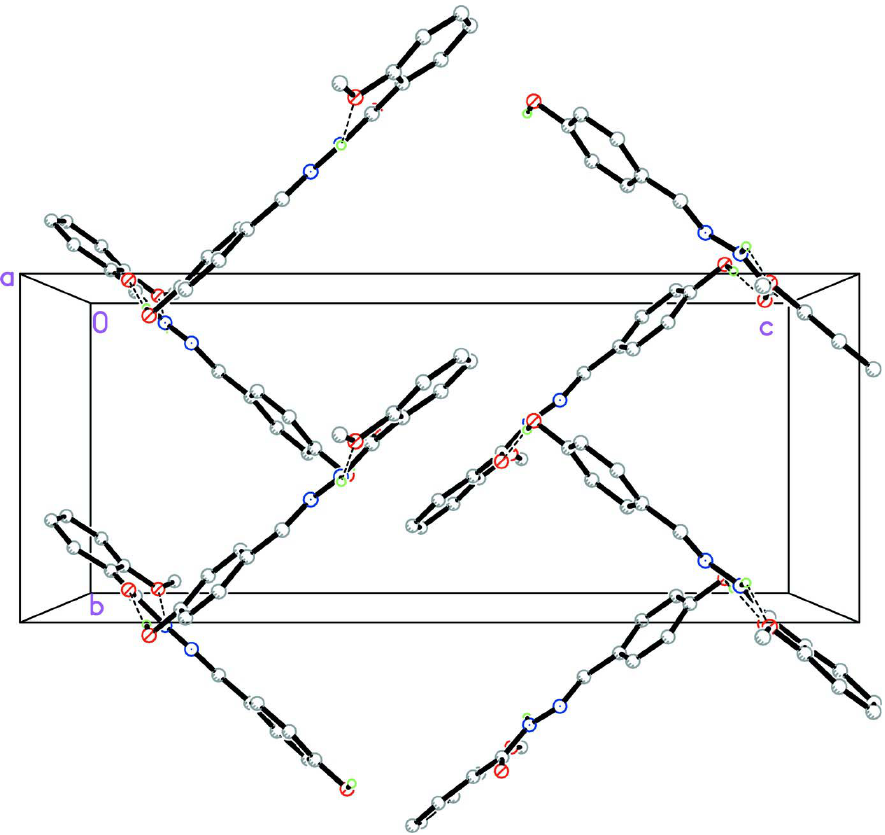
Figure 2 The crystal packing of compound (I), viewed along the a axis. Hydrogen bonds are shown as dashed